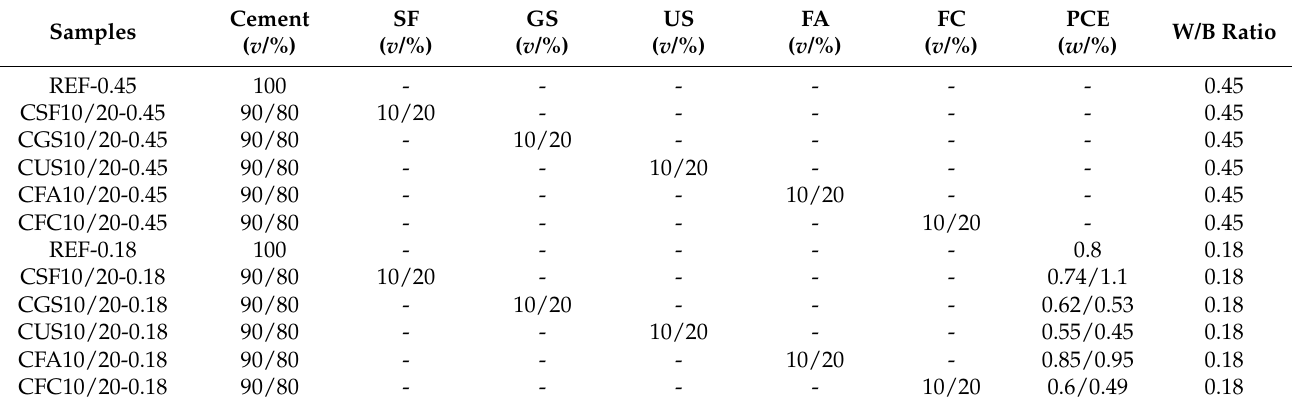
Table 4. Mix proportions of